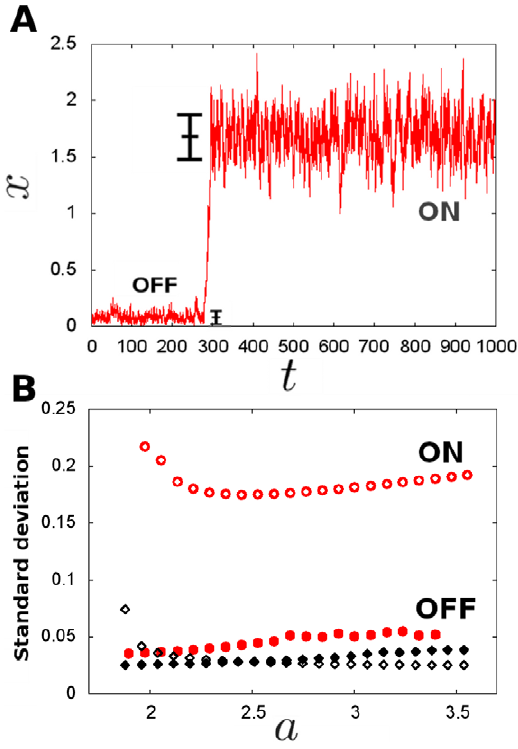
Figure 2. Intrinsic multiplicative noise drives larger absolute fluctuations in the ON state. A Time evolution of the concentration x for a ~ 2 : 18 . Error bars denote the fluctuations size in each state, which is much higher in the ON state. B Fluctuations in the OFF steady state (filled symbols) and in the ON steady state (empty symbols) for the multiplicative noise model (red) and for the additive noise model (black). Fluctuations are measured as the standard deviation from the steady state. For the multiplicative noise model, fluctuations in the ON state are larger than in the OFF state. For the additive noise model, fluctuations in the OFF and ON states are similar. Standard deviations have been computed over samples of sizes ranging from 100 to 1000 repetitions of the corresponding Langevin dynamics at time t=100. For the additive noise model we have used a different B 0 value for each a , as explained in section 3 in Methods.